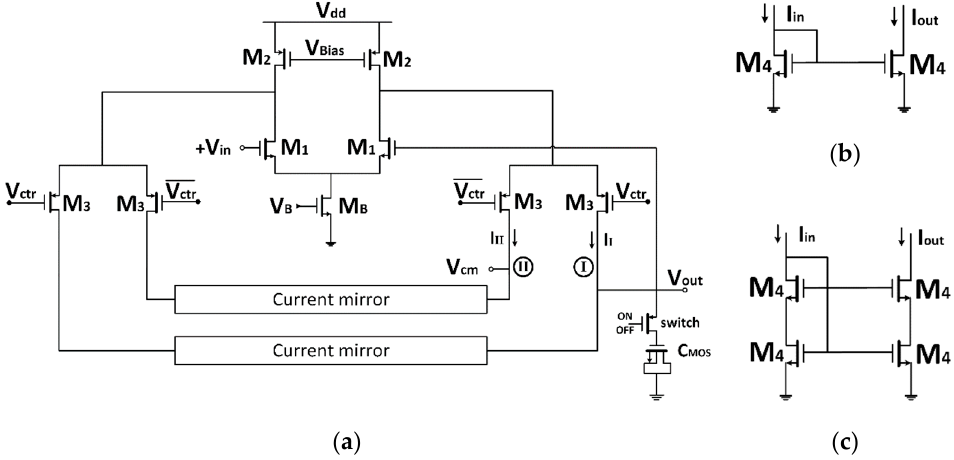
Figure 5. Schematic view of the: ( a ) proposed folded-OTA based LPF, ( b ) classic current mirror